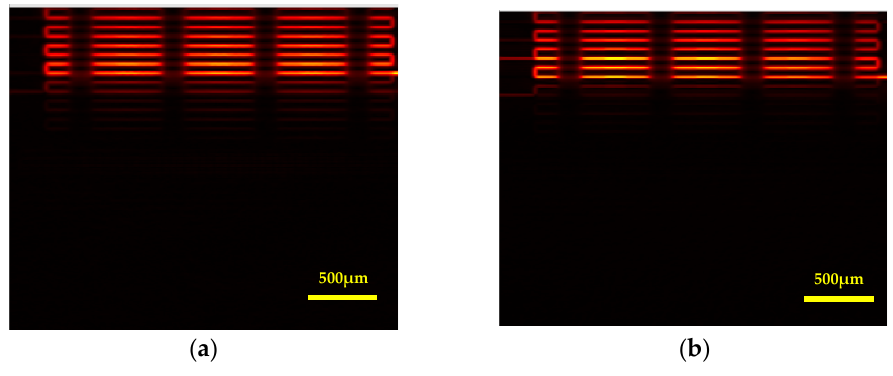
Figure 5. RF scan from pin J12: ( a ) Reference sample; ( b ) Failed sample. Two RF probes were connected to pins J3 and J12 (Channel 6) at the same time. Some